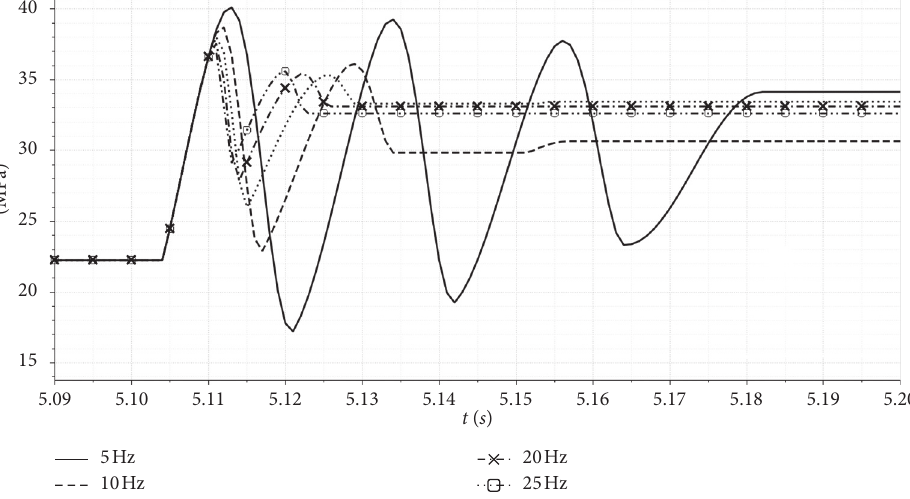
Figure 8: Different natural frequencies of relief